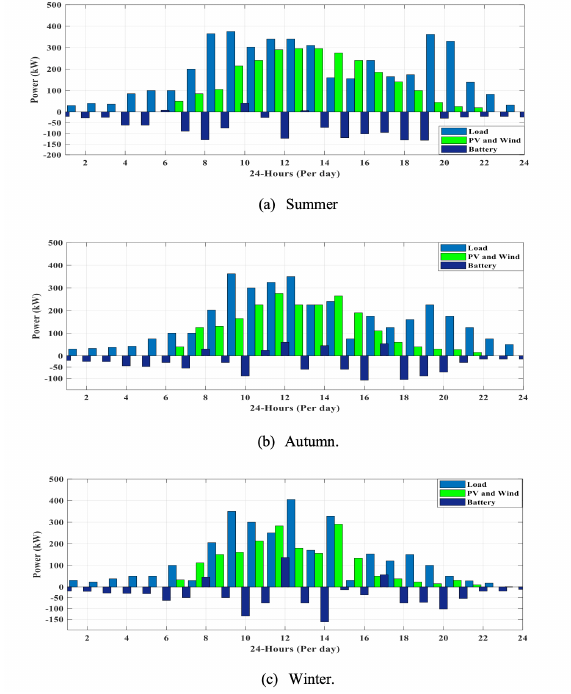
Fig. 7. Generation of power from PV, Wind and Battery energy sources in summer, autumn and winter